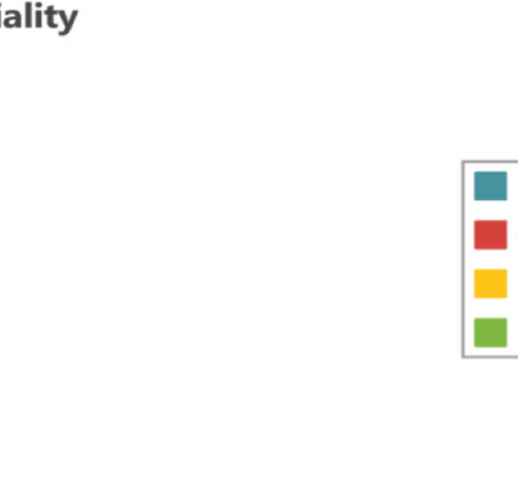
Figure 8. Data confidentiality of past